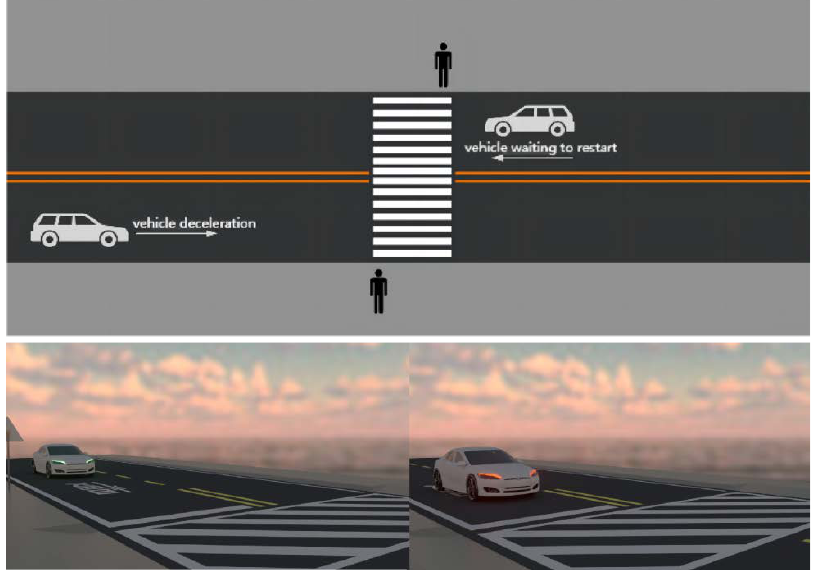
Figure 1. Scene design of animated film.